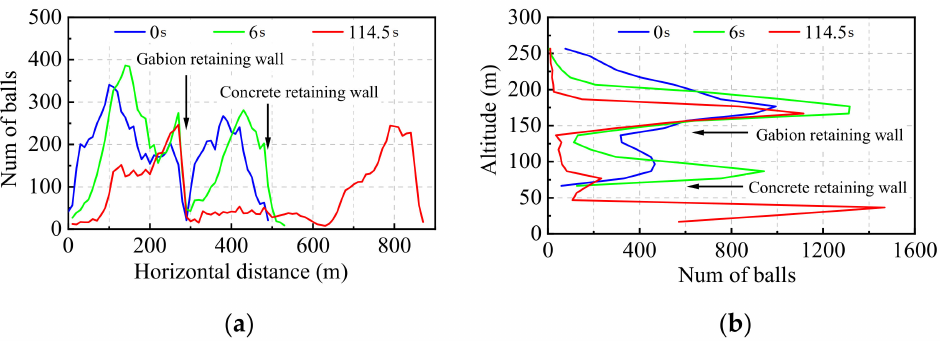
Figure 17. Distribution of the rockfill stone before and after slope instability: ( a ) Horizontal distribu- tion; ( b ) Vertical